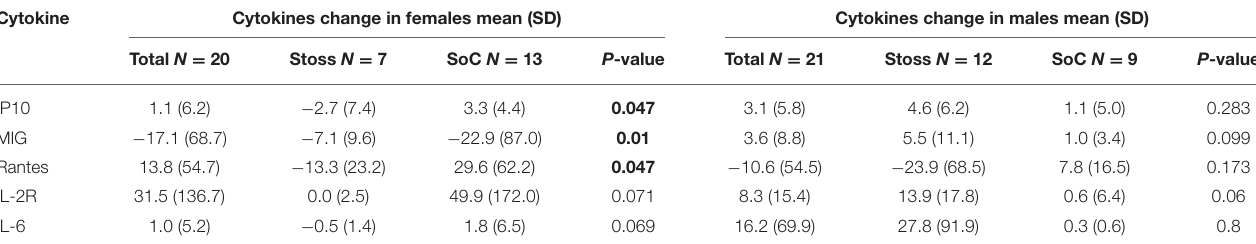
Bold values indicate the SD: standard